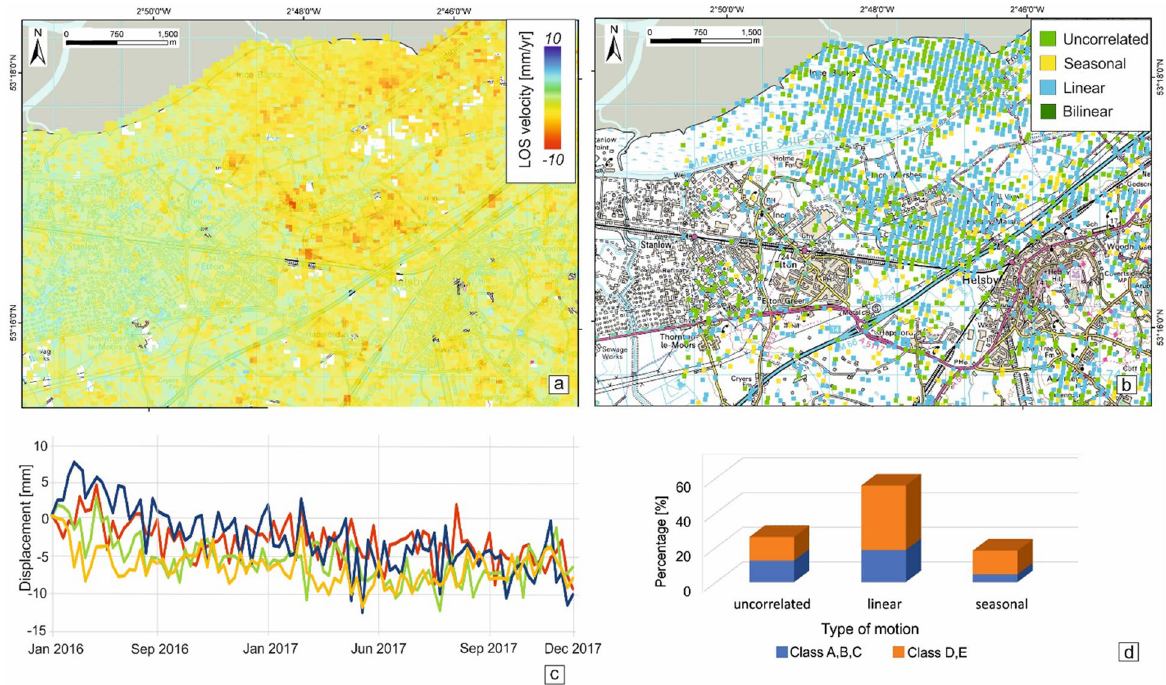
Figure 5. Ground stability condition for the Cheshire Observatory during 2016–2017. ( a ) ISBAS results from Sentinel-1 data, ( b ) classification of the unstable InSAR time series, ( c ) time series for four ISBAS points within and database right 2018, license number 100021290 EUL. Contains British Geological Survey materials, UKRI 2021. Contains Terra Motion Limited 2017